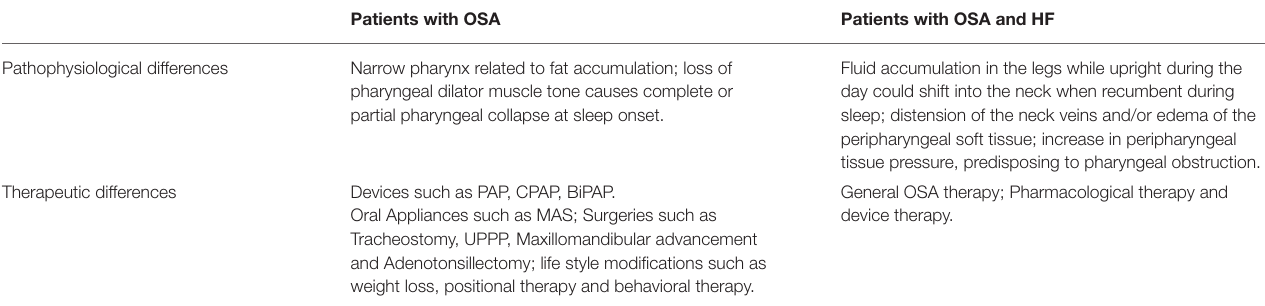
TABLE 2 | Pathological and therapeutic differences between OSA patients with HF and general population. Patients with OSA Patients with OSA and HF Pathophysiological